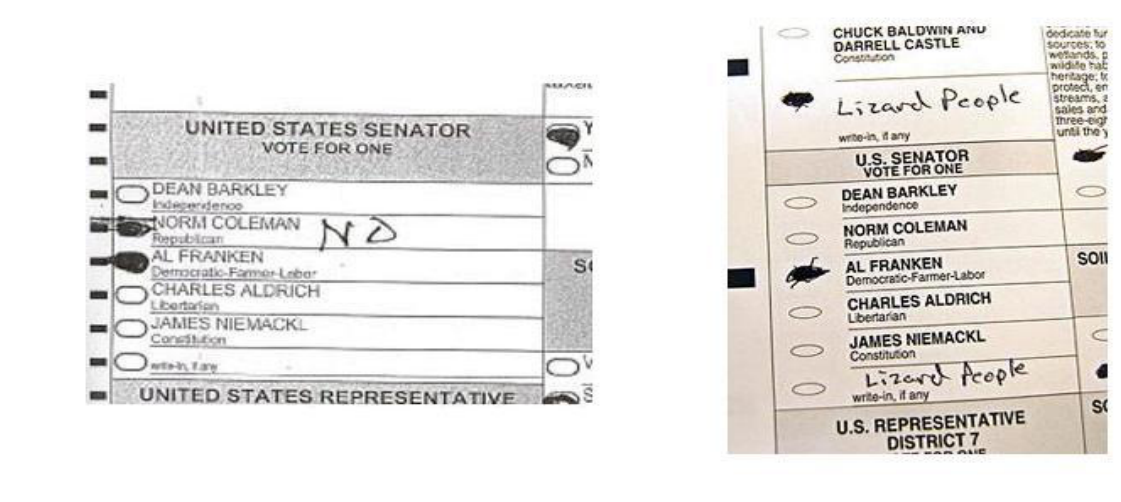
Figure 2: Left: This ballot was challenged in Dakota County because two ovals were filled in. Minnesota law says a ballot is valid if election officials can determine the voter’s intent. Right: The voter cast the ballot for Al Franken, but also put ”Lizard People” as a write -in candidate, not only in the U.S. Senate race, but for several others. The county auditor/treasurer ruled that the vote should not be counted becau se it’s considered an overvote (Tibbetts & Mullis,